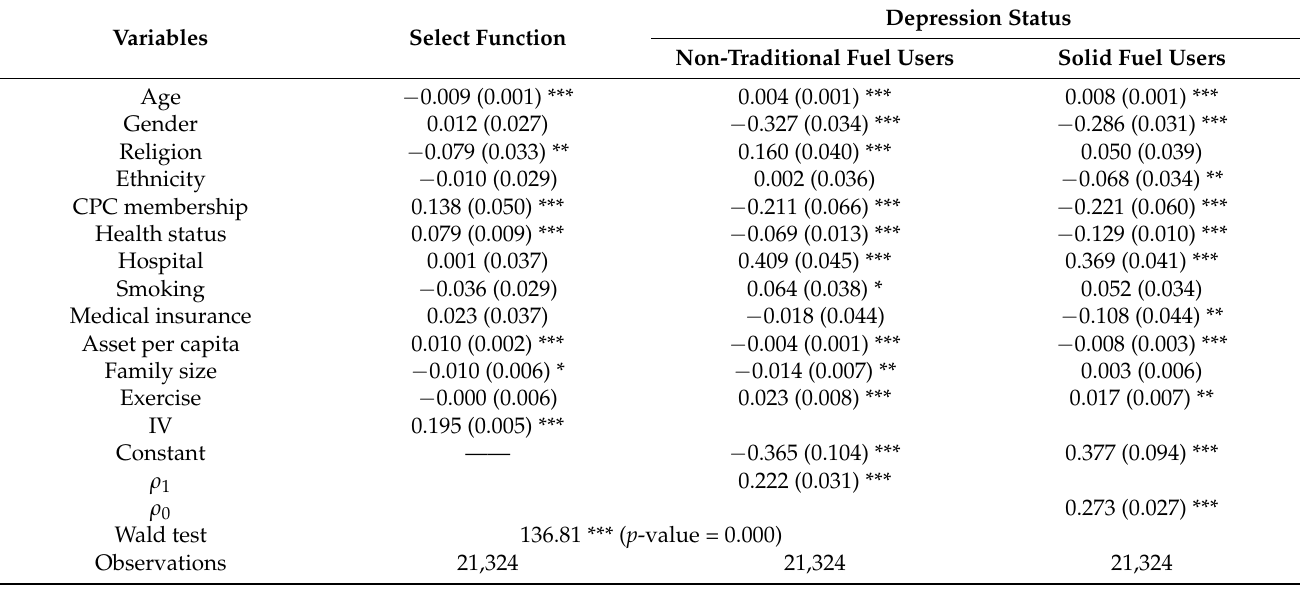
Table 4. The coefficients and standard errors of ESP model for the effect of non-traditional fuel choices on depression